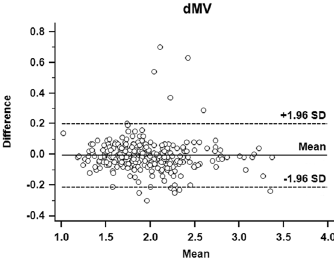
Figure 4. Bland–Altman analysis of the agreement between the investigators for membrane-to-vallecula distance (dMV) measurements. The differences between the investigators are plotted against the averages of the two